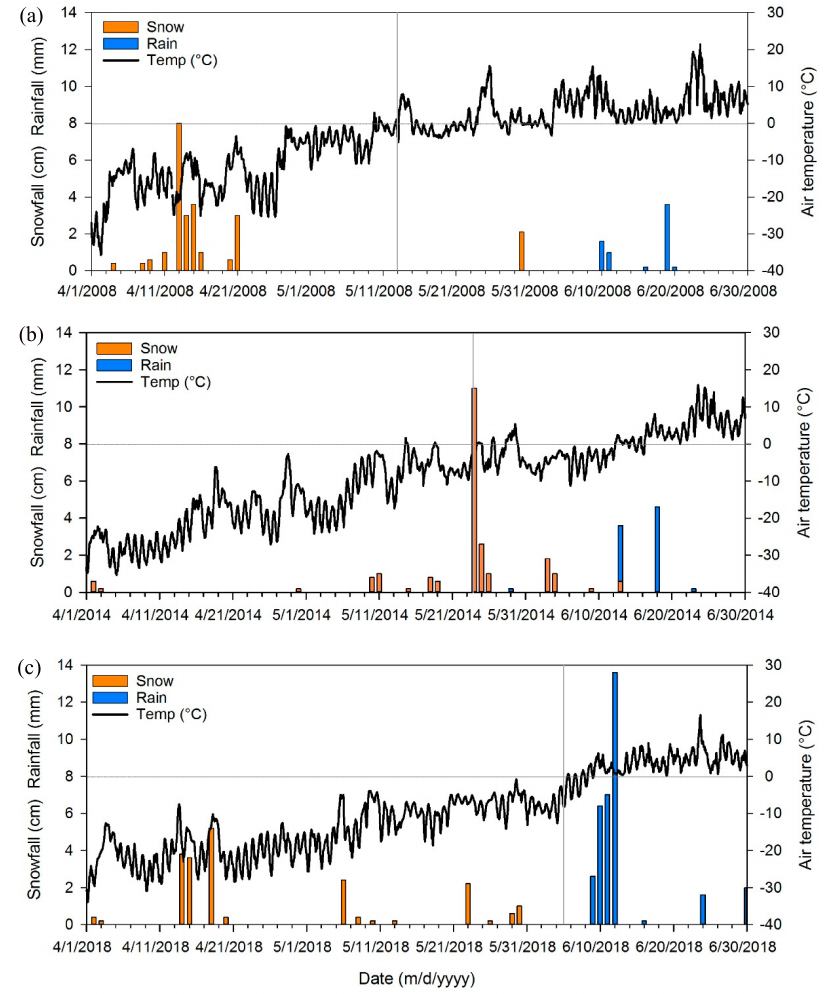
Figure 3. Hourly air temperature and daily precipitation total for Franklin Bay, 2008 (measured at Cape Parry Environment and Climate Change station) ( a ), Cambridge Bay, 2014 (measured at Cambridge Bay EEEC station) ( b ) and 2018 ( c ) (measured at the on-ice station). Thin horizontal and vertical grey lines correspond to the freezing mark and date of melt onset (MO),